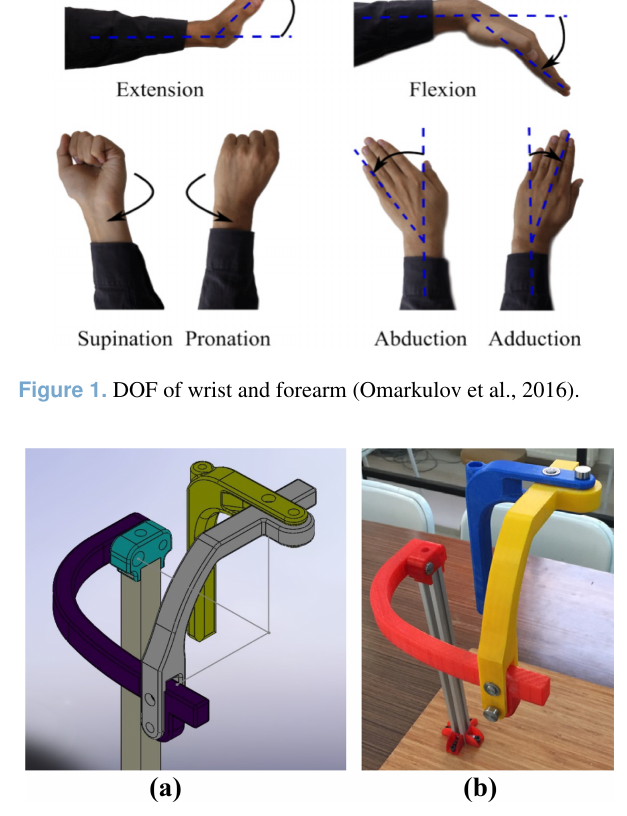
Figure 2. The solid and manufactured model of the designed ex- oskeleton.